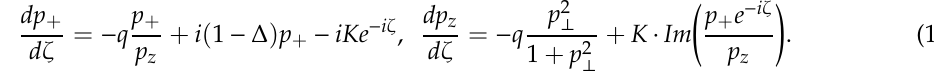
, surface density  = 1.2 ∗10  /  , , surface density σ = 1.2 · 10 − 4 C / m 2 ,  0